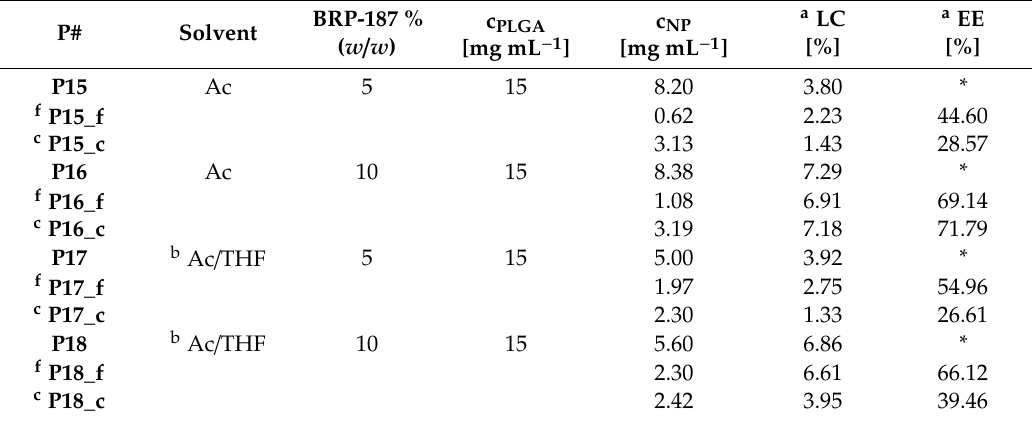
Table 2. PLGA(BRP-187) particle characteristics before and after additional